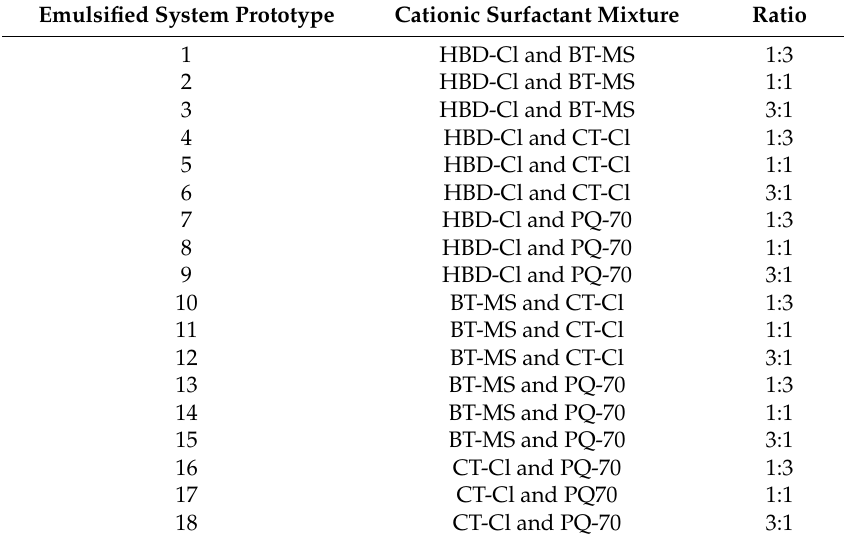
Table 2. Designing the cationic surfactant mixture for the hair conditioner